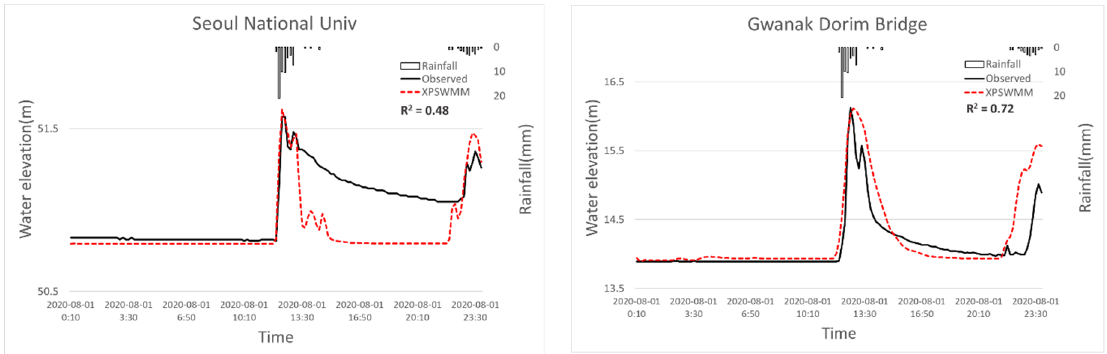
Figure 6. Calibration results of pump station (01 August 2021).